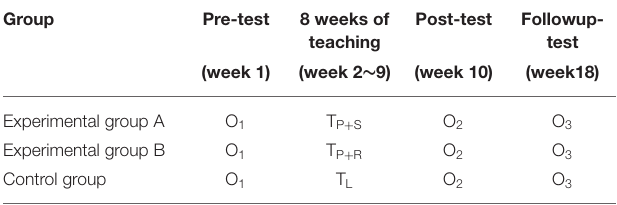
TABLE 1 | Experimental procedure of three groups.